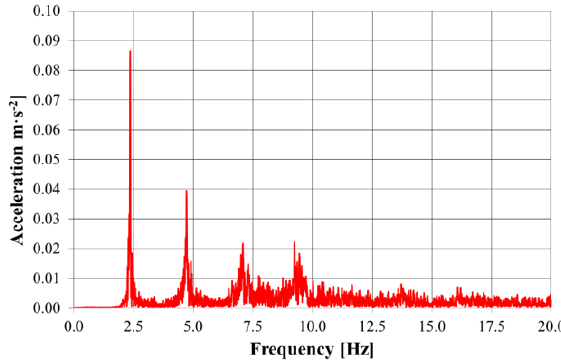
Figure 7. Frequency at Letna in 2013